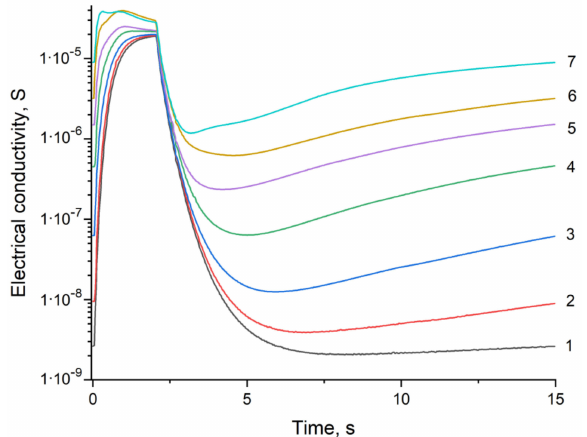
Figure 2. Change in electrical conductivity of the SnO 2 –PdO x sensor for carbon monoxide concentra-